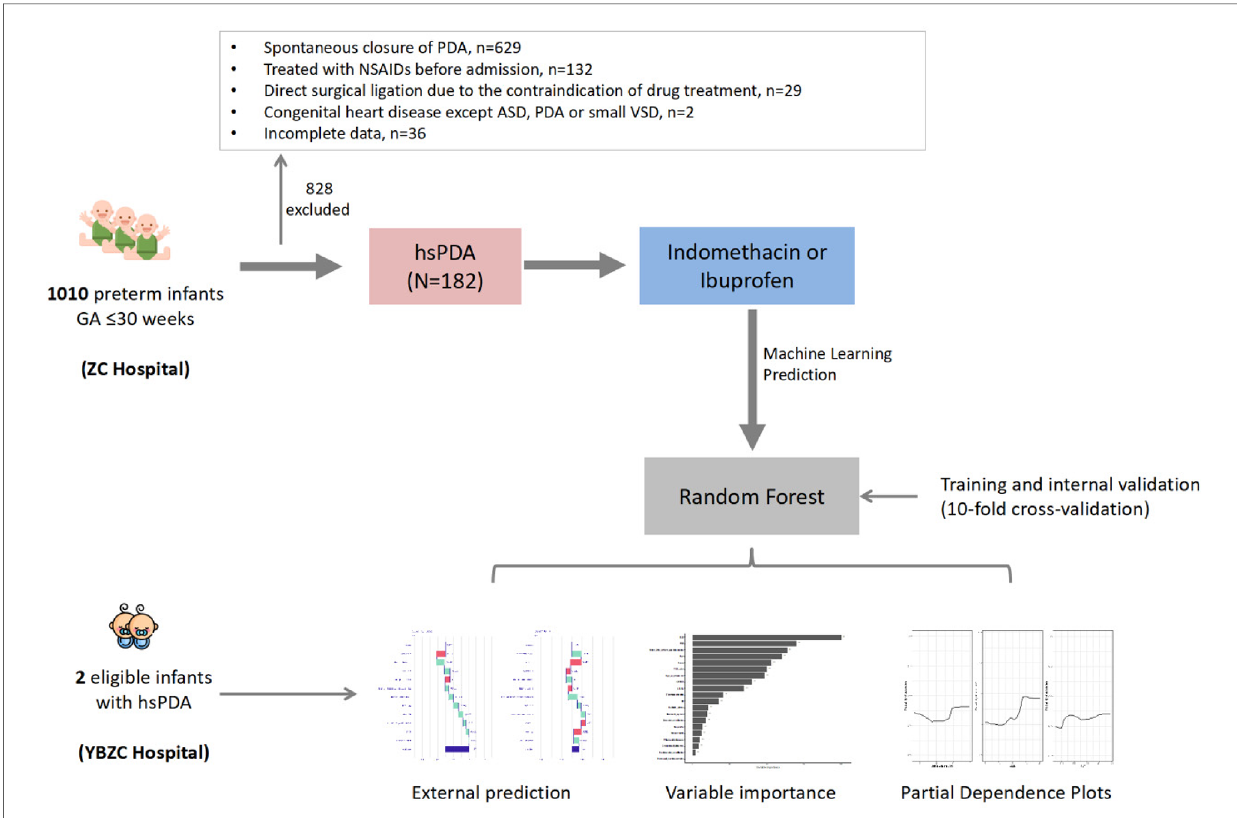
FIGURE 1 Graphic abstract. GA, gestational age; PDA, patent ductus arteriosus; ASD, atrial septal defect; VSD, ventricular septal defect; hsPDA, haemodynamically signi fi cant patent ductus